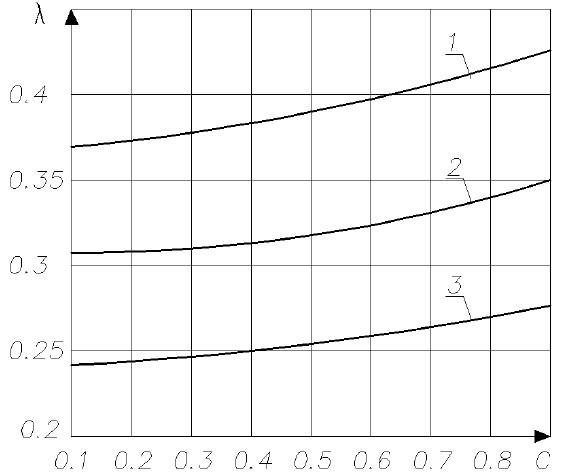
Figure 4. Dependence of the tension side height λ on the stress at the crack tip c : 1 on z = 0.1; 2 on z = 0.2; 3 on z = 0.3.